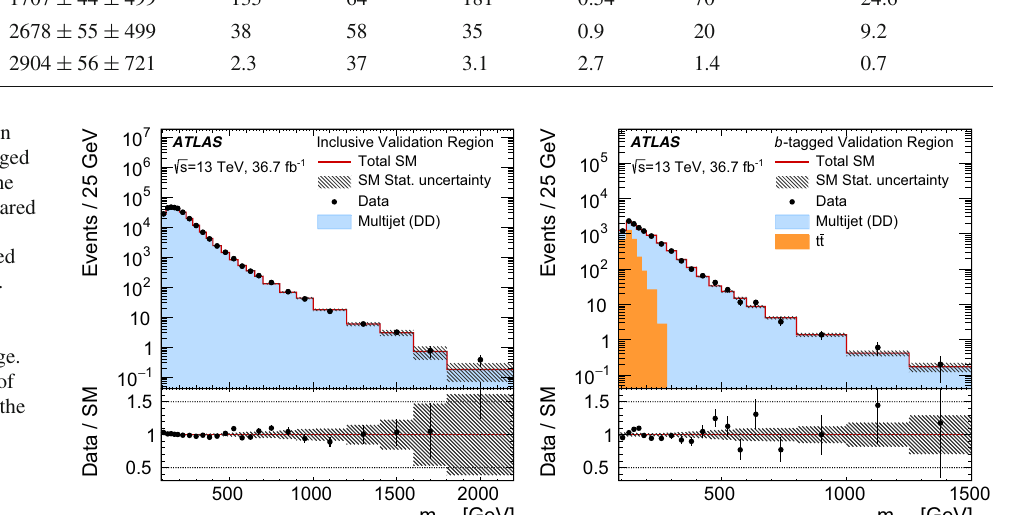
Fig. 6 The m avg spectrum in the inclusive (left) and b -tagged (right) validation regions. The data (black points) are compared to the total background prediction (red line) estimated with the data-driven method. The fraction of background coming from top-pair production is shown in orange. The statistical uncertainties of the prediction are shown by the grey hatched